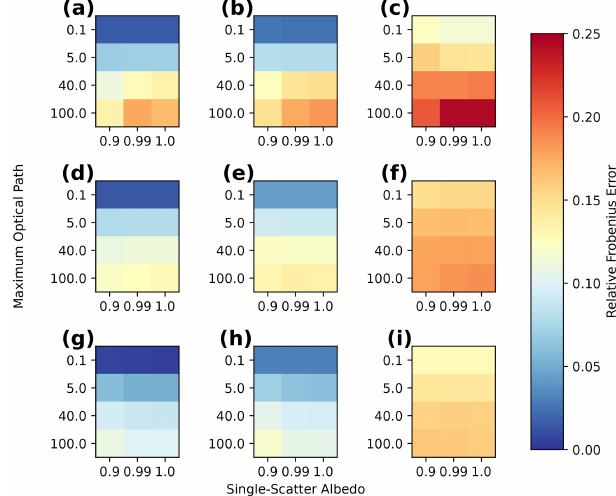
Figure 10. The relative Frobenius error (Eq. 67) of the approxi- mate Jacobian with respect to the finite-differenced Jacobian for the same 3D Gaussian clouds, as used in Fig. 5. Panels (a) , (b) , and (c) have isotropic phase functions. Panels (d) , (e) , and (f) have Mie phase functions, and panels (g) , (h) , and (i) have Mie phase func- tions with a reduced angular resolution (see text for details). Pan- els (a) , (d) , and (g) have a black surface. Panels (b) , (e) , and (h) have Lambertian surface albedos of 0.2, while panels (c) , (f) , and (i) have Lambertian surface albedos of